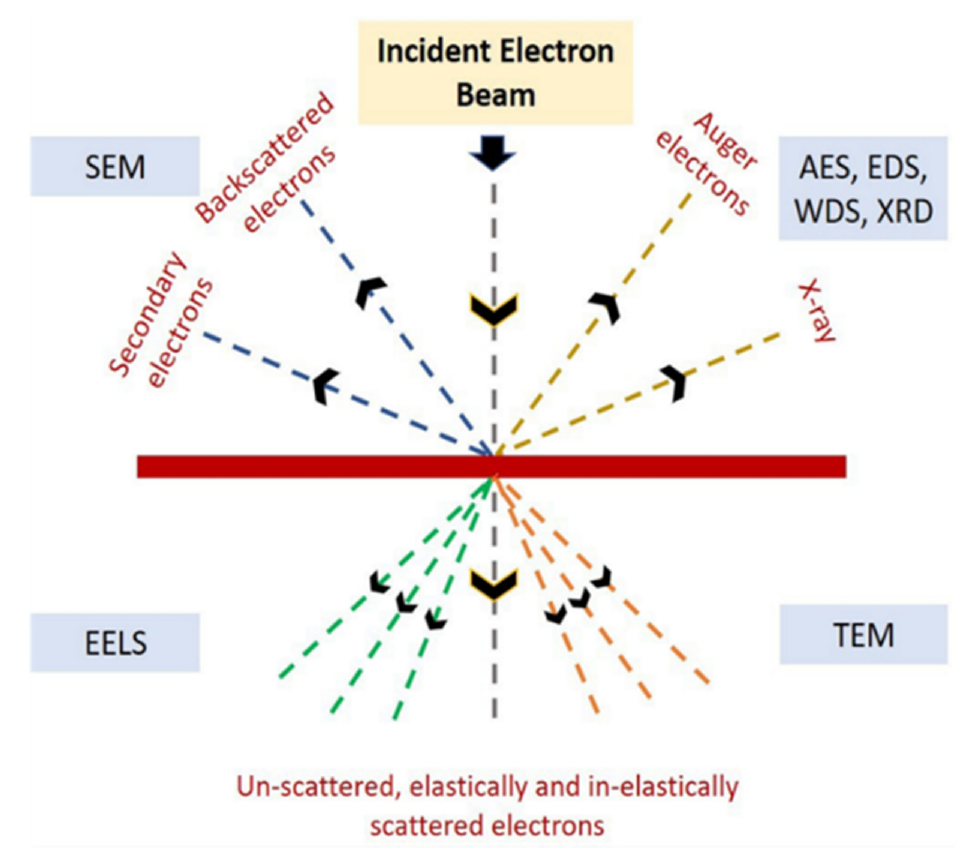
Figure 3. Various interaction products during an incident electron beam and a